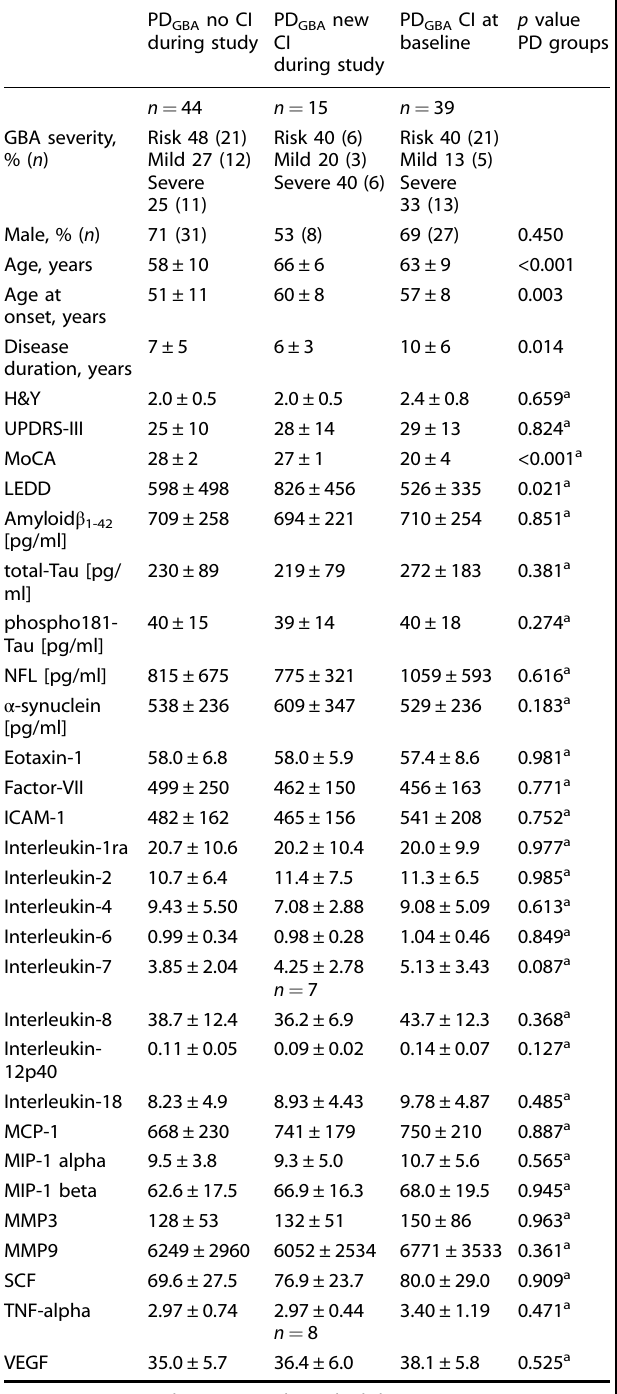
Table 6. Baseline demographic, clinical and in fl ammatory data from people with Parkinson´s disease with GBA mutation strati fi ed by cognitive